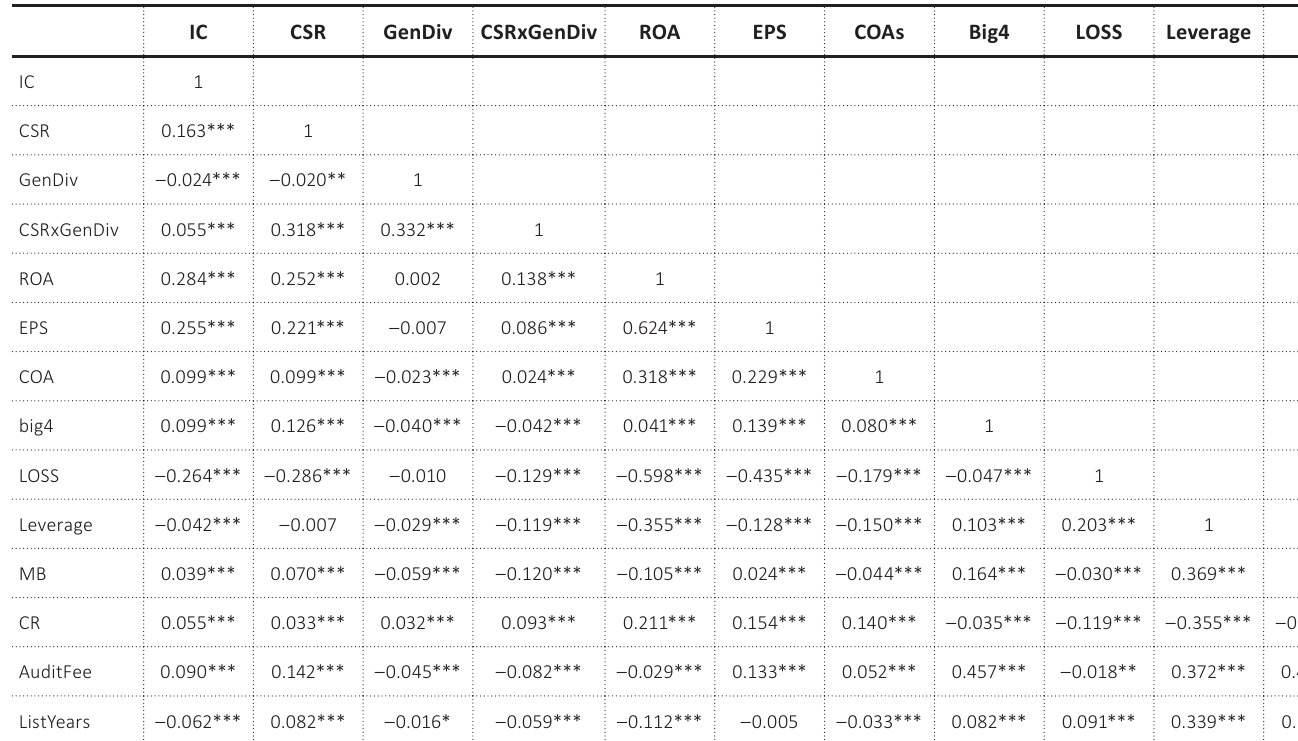
Table 6. Pearson correlation